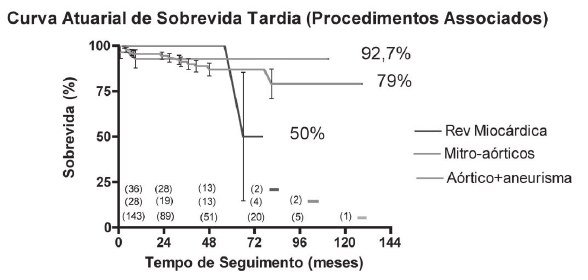
Fig. 4 - Curva atuarial de sobrevida estratificada por procedimentos associados, em 282 pacientes submetidos à substituição da valva aórtica por homoenxerto valvar aórtico.